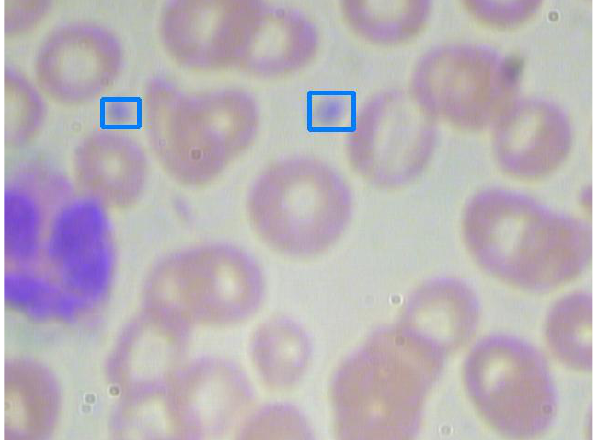
Figure 10. An image with unobvious platelets.